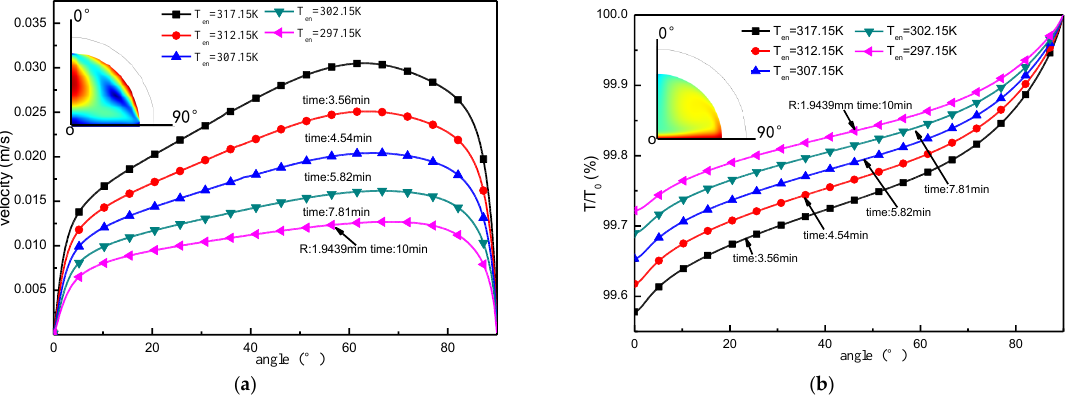
Figure 14. Variation of the physical field on the liquid surface boundary line for different ambient temperature conditions when the droplets evaporate to the same radius. ( a ) Variation in droplet surface flow rate; ( b ) Change in droplet surface temperature.